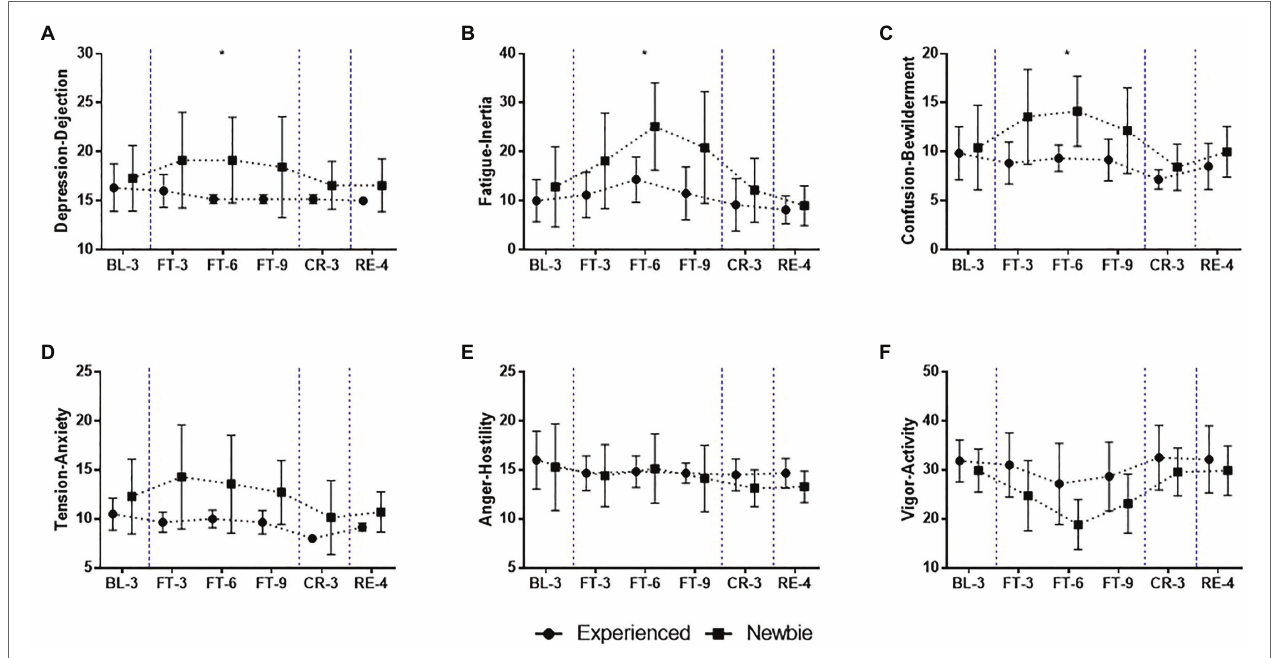
FIGURE 4 | Mean and SD of mood state scores over the 22-day experiment for the Experienced and Newbie groups. (A-F) The scores of the subscales of the profile of mood states (POMS). Symbols represent mean scores for the two groups, and error bars represent the SD of the mean. * p < 0.05 indicates significant differences between the two groups at a given test point. Blue dashed lines indicate the different